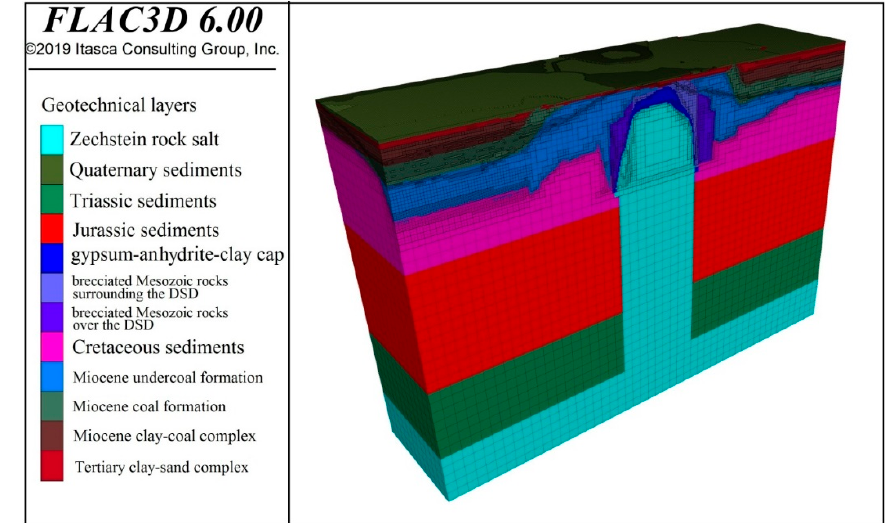
Figure 5. A numerical model of the DSD and surrounding area.